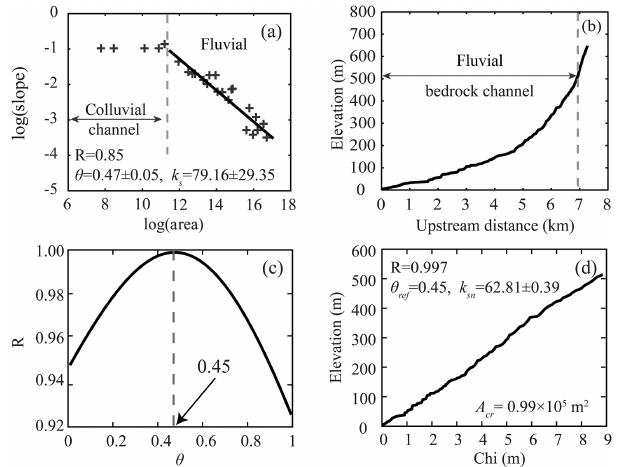
Figure 3. Stream profile analysis of Cooskie stream. (a) Log- transformed slope–area plot. The slope was derived from the smoothed (horizontal distance of 300m) and re-sampled (elevation interval of 20m) elevation data. (b) The full river profile (without any smoothing or re-sampling) of Cooskie stream. (c) The correla- tion coefficients, R , as a function of θ for least-squares regression based on Eq. (5). The maximum value of R , which corresponds to the best linear fit, occurs at θ = 0.45 (dotted line and black arrow). (d) χ − z plot of the bedrock channel profile, transformed according to Eq. (3) with θ = 0.45, A cr = 0.1km 2 , and A 0 = 1m 2 .